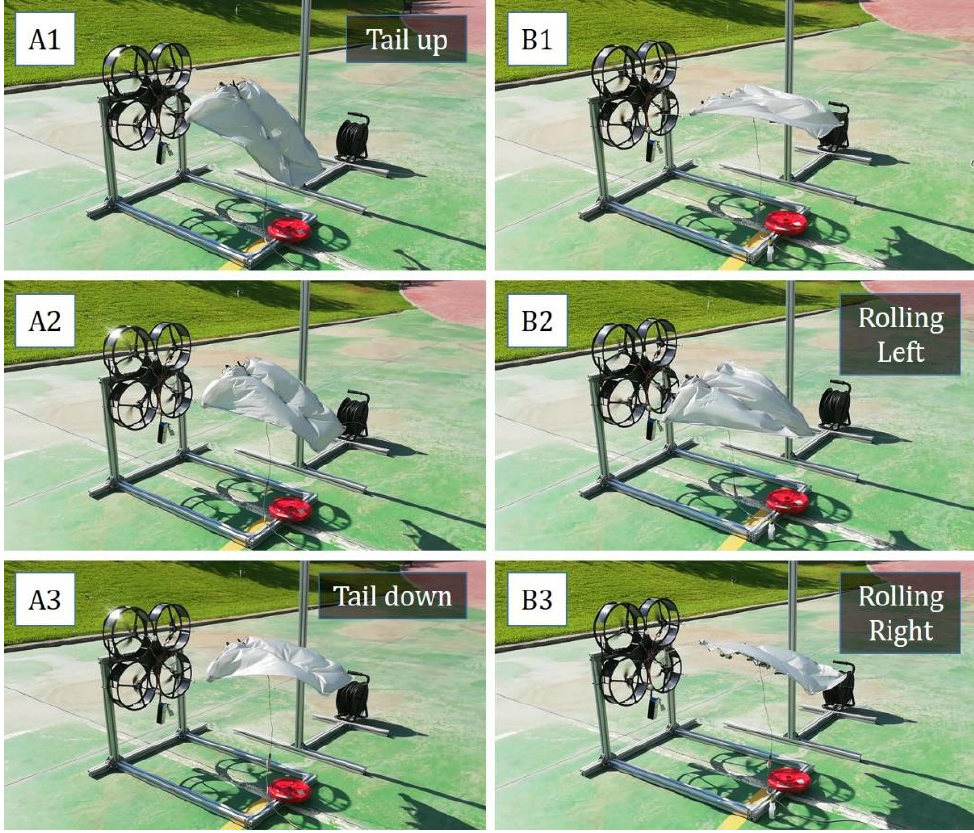
Figure 19. Wind tests conducted in an outdoor testbed. Tail pitching up ( A1 ), horizontal ( A2 ) and down ( A3 ). Shoulder rotation, flat pose ( B1 ), rolling left ( B2 ) and right ( B3